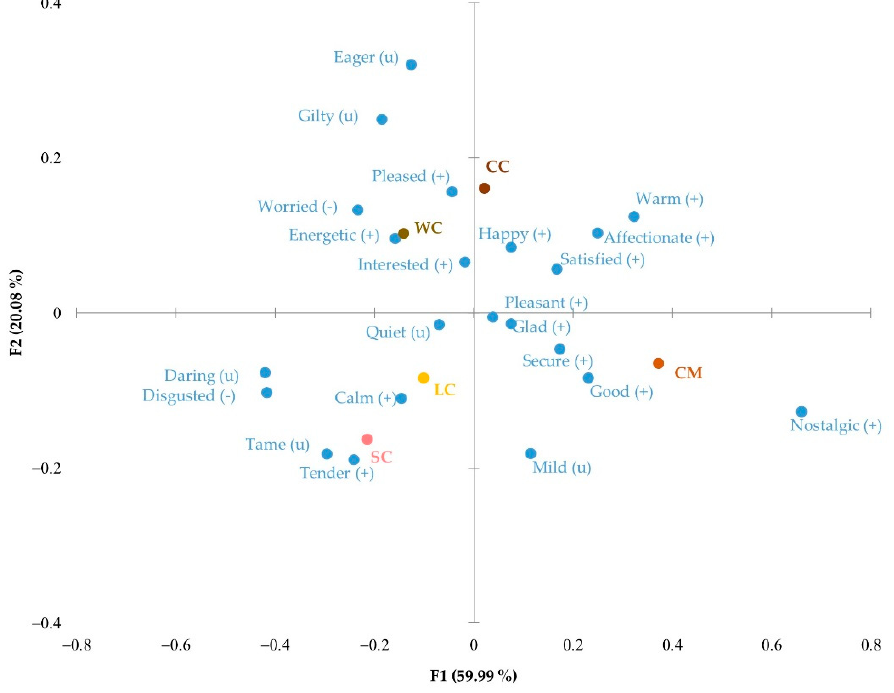
Figure 3. Correspondence analysis of the significant emotional responses obtained with CATA EsSense Profile™: (+), positive emotion; ( − ), negative emotion; (u), neutral emotion; WC, Walnut cake; LC, Leonor cake; SC, Saffron cake; CC, Coulant cake; CM, Chocomuffin.